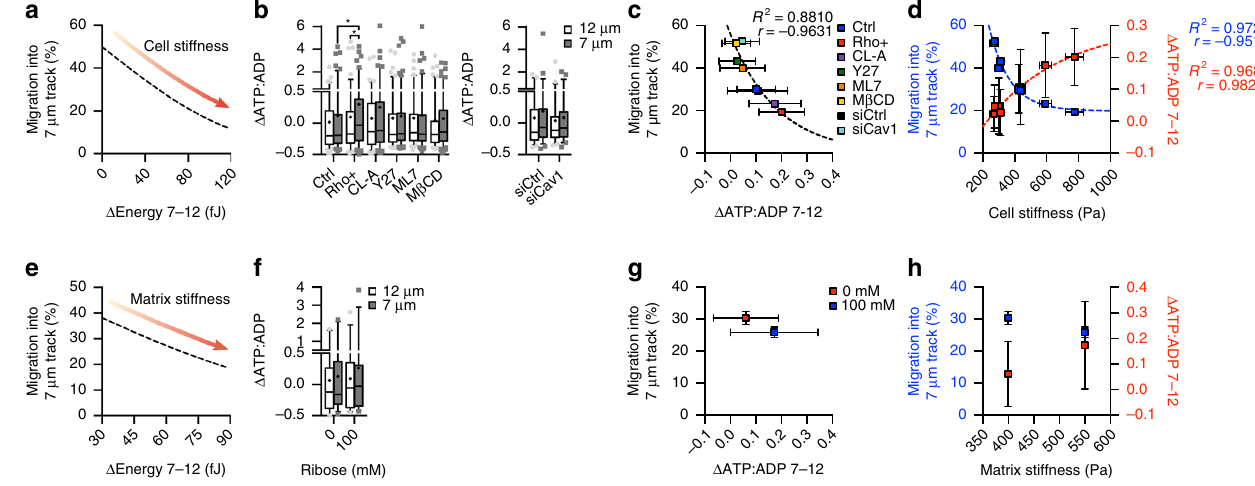
Fig. 6 Energetic costs between migration choices govern migration decision-making. a Model predictions for migration choice as a function of the difference in energetic costs between migration paths with increasing cell stiffness. b Δ ATP:ADP for migration into the 12 and 7 μ m microtrack following pharmacological treatments and siCav1 knockdown ( n = Ctrl: 91, 118; Rho + : 92, 107; CL-A: 95, 100; Y27: 117, 135; ML7: 95, 107; M β CD: 105, 123; siCtrl: 49, 53; siCav1: 46, 55 cells for 12 μ m and 7 μ m microtracks). c Percentage of migration into the 7 μ m microtracks as a function of Δ ATP:ADP 7 – 12 with changes in cell stiffness; dashed line shows one-phase decay. d The inverse relationship between migration frequency into the 7 μ m microtracks and Δ ATP:ADP 7 – 12 as a function of cell stiffness across treatments; dashed line shows one-phase decay for migration into 7 μ m and one-phase association for Δ ATP:ADP 7 – 12. e Model predictions for migration choice as function of energetic cost with increasing matrix stiffness. f Δ ATP:ADP between migration paths with changing matrix stiffness ( n = 0 mM: 30, 31; 100 mM: 31, 29 cells for 12 μ m and 7 μ m microtracks). g Percentage of migration into the 7 μ m microtracks as a function of Δ ATP:ADP 7 – 12 with changes in matrix stiffness. h The inverse relationship between migration frequency into the 7 μ m microtracks and Δ ATP:ADP 7 – 12 as a function of matrix stiffness. Data shown as median± interquartile range (box), 5th – 95th percentiles (whiskers), and mean ( + ) ( b , f ), or mean ± s.e.m. ( c , d , g , h ); two-tailed Mann – Whitney test ( b , f ); * P <